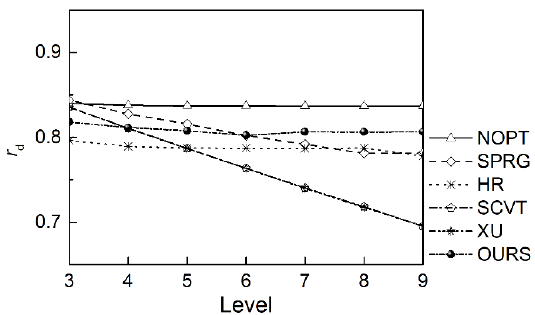
Figure 9. The normalized minimum and maximum distance of different grids. Ratios between the minimum and maximum distances, r d = d min / d max , of different grids at different resolutions are calculated in Table 7 and presented in Figure 10.